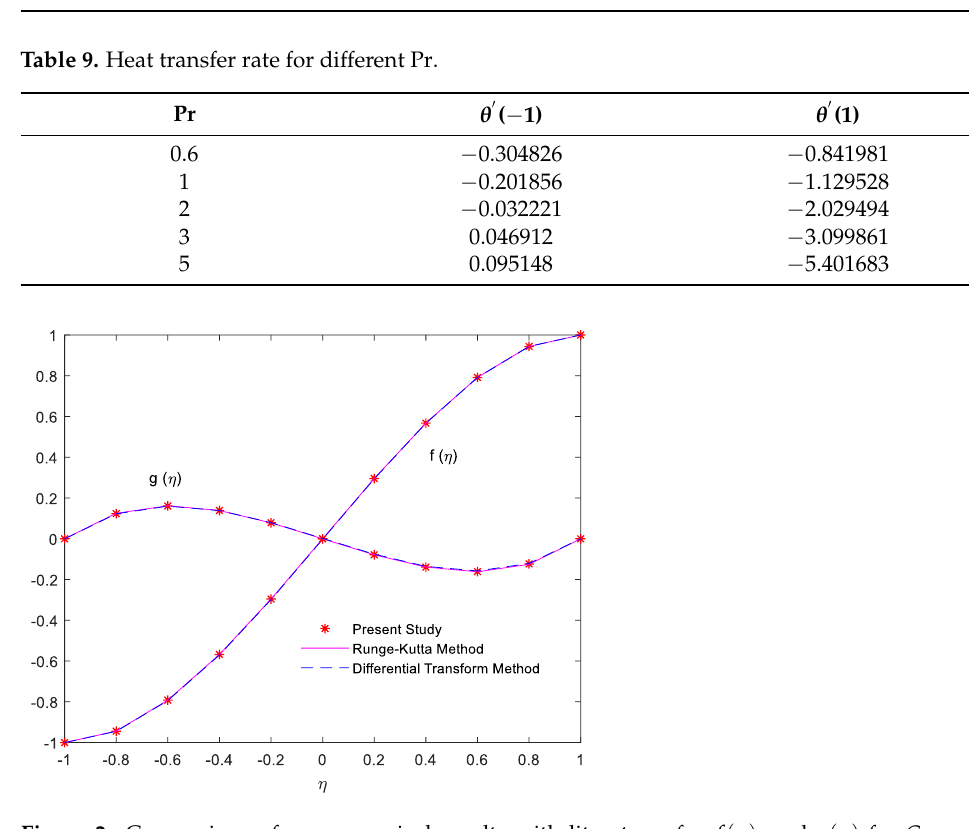
Figure 2. Comparison of our numerical results with literature, for f ( η ) and g ( η ) for C 1 = 0.1, C 2 = 1, C 3 = 0.1, M = 0, A = 0, and Re =